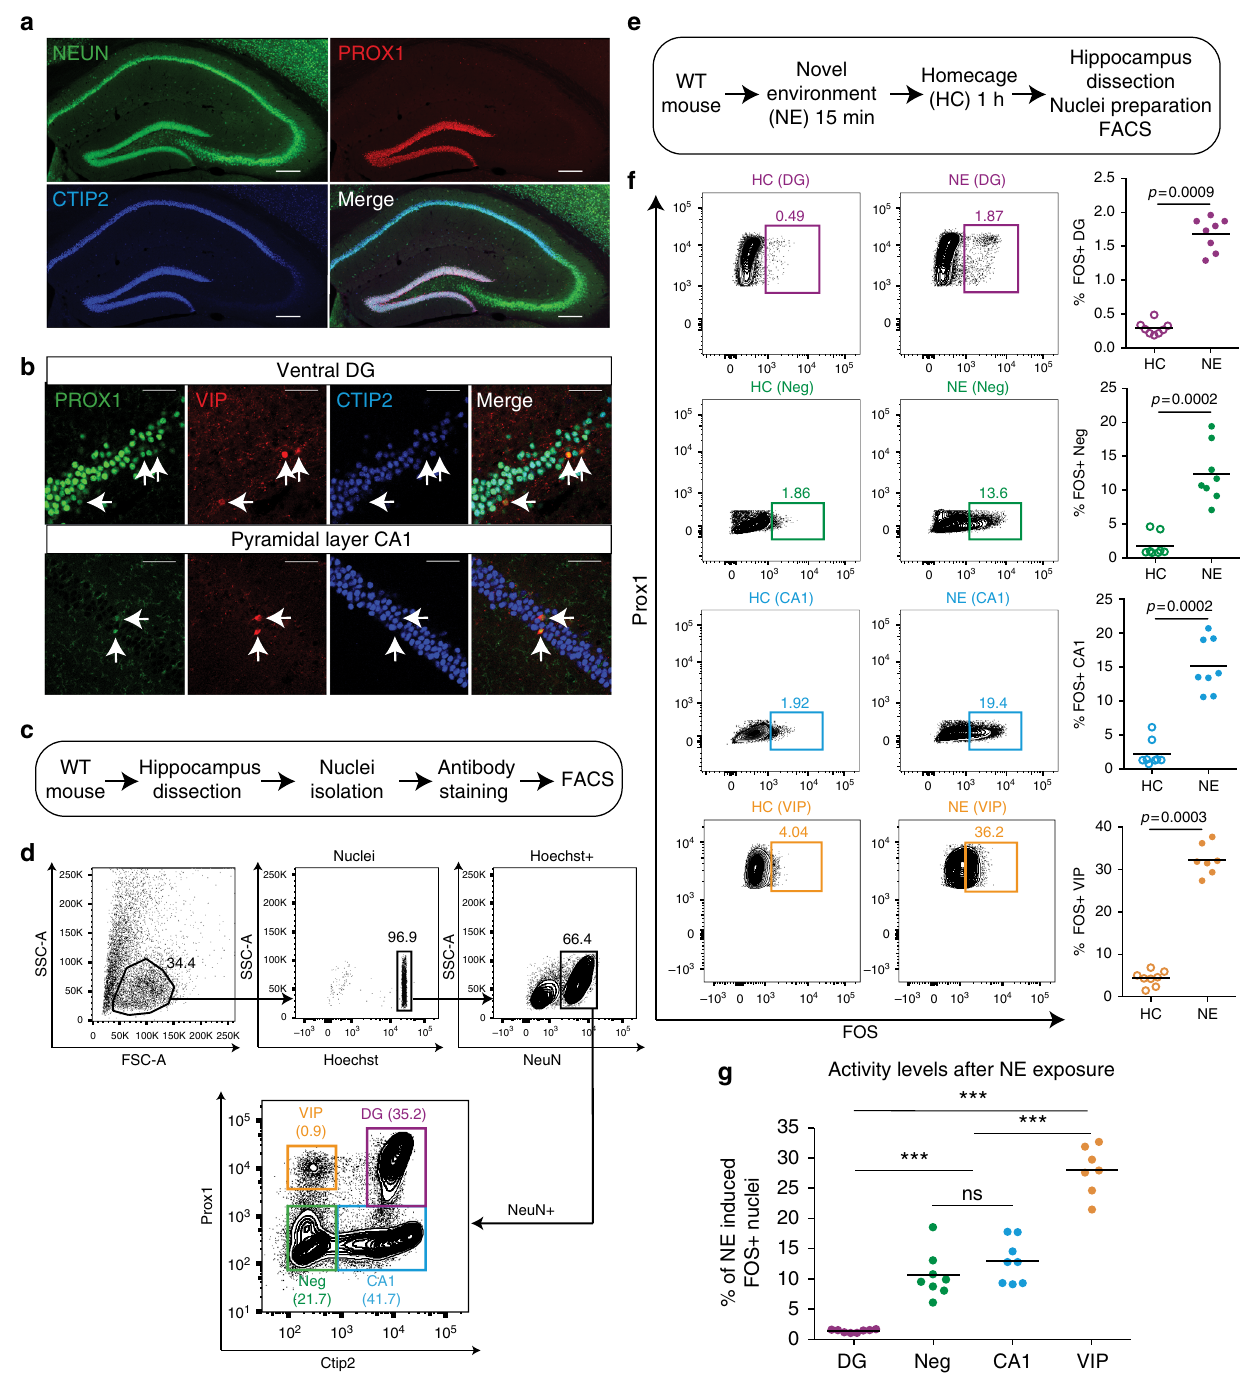
Fig. 1 Flow cytometry dissection of the hippocampus. a Confocal images of NEUN, PROX1, and CTIP2 protein expression in the hippocampus. Scale bars = 200 μ m. b PROX1 + CTIP2 − VIP + interneurons (arrows) are found in the dentate gyrus (DG) and CA1. Scale bars = 50 μ M. c Work fl ow for fl ow cytometry dissection of the hippocampus. d Representative FACS plots showing expression of NEUN, PROX1, and CTIP2 in hippocampal nuclei from 7- to 8-week-old mice ( n = 8). 65% (SD ± 6%) of isolated nuclei were NEUN + . Among NEUN + nuclei, 38% (SD ± 4%) were DG neurons (PROX1 + CTIP2 + ), 45% (SD ± 6%) were CA1 (PROX1 − CTIP2 + ), 10% (SD ± 3%) were Negs (PROX1 − CTIP2 − ), and 1% (SD ±0.4%) were VIP interneurons (PROX1 + CTIP2 − ). e Work fl ow for the fl ow cytometry dissection of the hippocampus following novel environment (NE) exposure. f Representative FACS plots showing expression of PROX1 and FOS in each population after home cage (HC) or NE exposure. Percentages of FOS + nuclei are displayed above gates. At least 200,000 NEUN + PROX1 + CTIP2 + nuclei were analyzed per mouse, n = 7 – 8 mice. P values are indicated for Mann – Whitney test. g NE-induced FOS expression in each population. Baseline activation in HC was subtracted from activated levels after NE exposure. n = 7 – 8 animals. Statistical difference between groups has been determined by one-way ANOVA ( F (3,27) = 84.9, p < 0.0001) and Tukey ’ s multiple comparisons test (*** = p < 0.0001, ns =